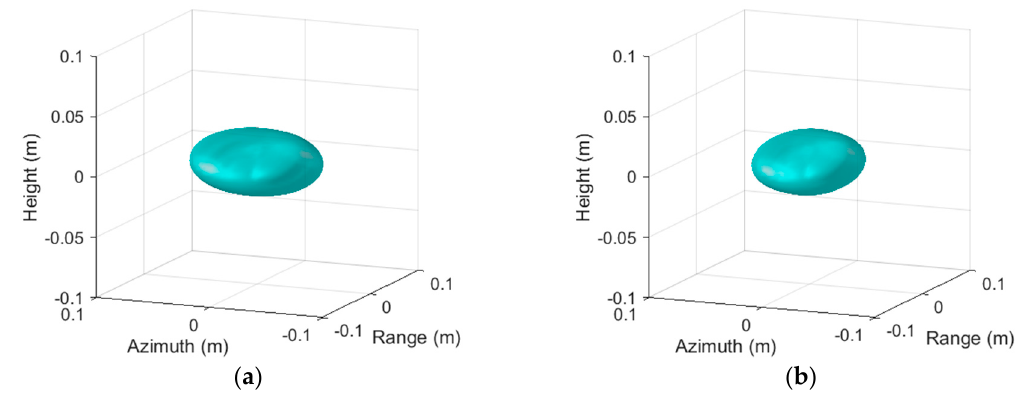
Figure 10. Final 3-D imaging result of the trihedral. ( a ) Equal-interval; ( b ) non-uniform.